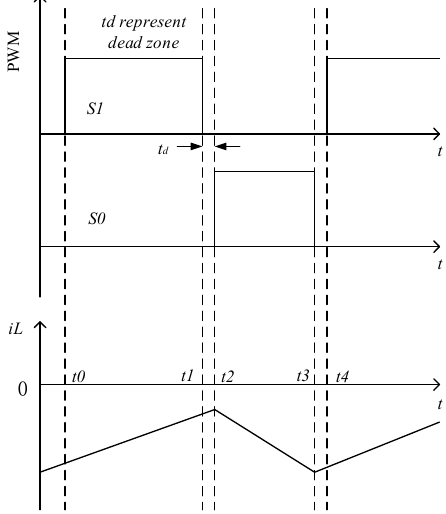
Figure 4. Equivalent circuit in buck mode.